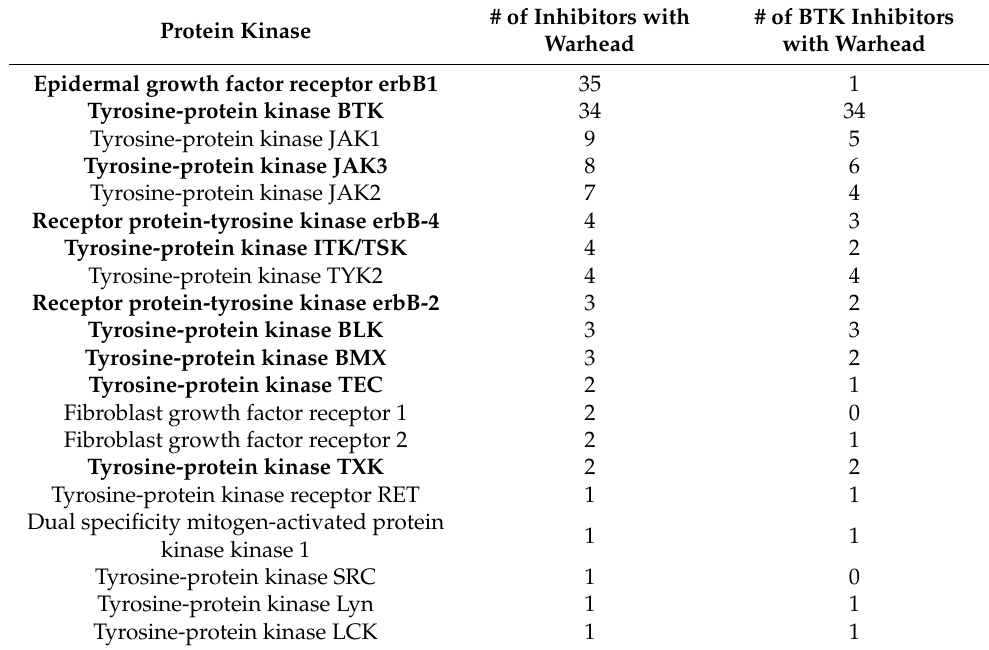
Table 1. Reported are inhibitors from ChEMBL containing the piperidine-based Michael acceptor warhead with activity against different kinases and their overlap with BTK inhibitors. Kinases with a free cysteine residue at a position corresponding to BTK are given in bold. # stands for Number. # of Inhibitors with # of BTK Inhibitors Protein Kinase Warhead with Warhead Epidermal growth factor receptor erbB1 35 Tyrosine-protein kinase